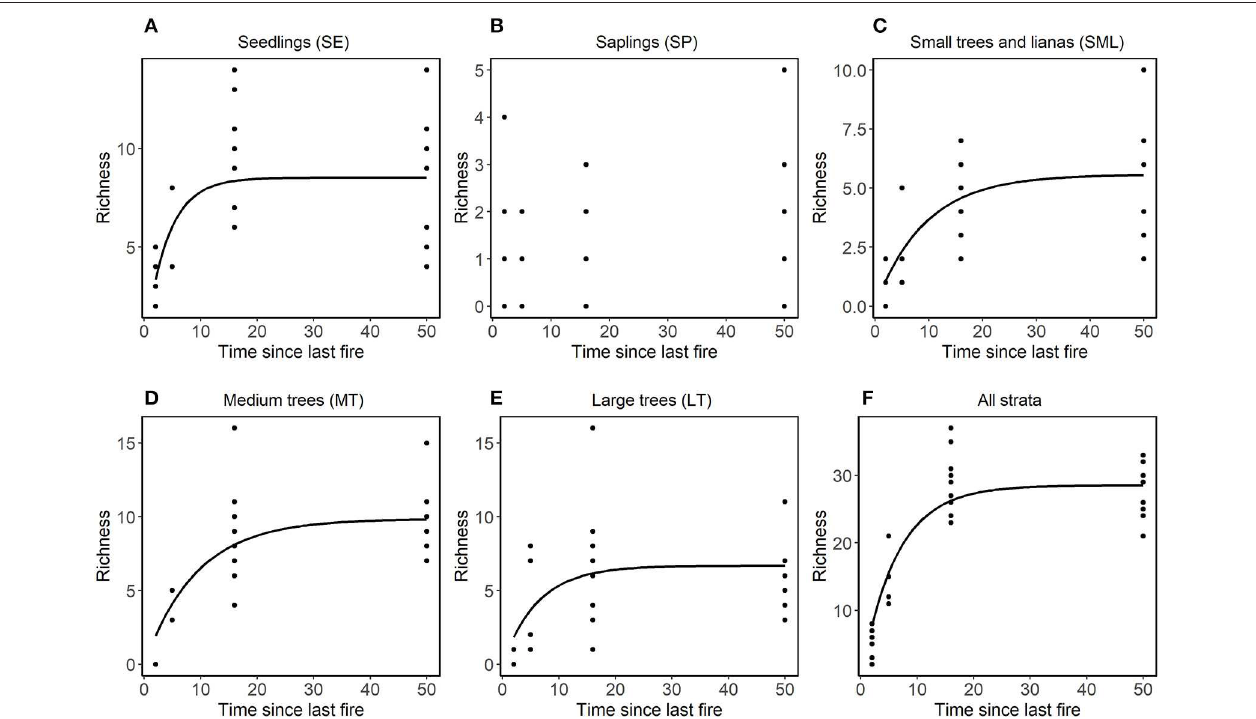
FIGURE 4 | Relationship in each stratum between richness and time since the last fire (years). In non-linear models fitted using (nls procedure in R) with asymptotic models, the equation was conducted separately for each stratum of vegetation (A) SE, (B) SP, (C) SML, (D) MT, and (E) LT, and (F) for all strata together. LT stands for large trees, MT for medium trees, SML for small trees and woody lianas, SP for seedlings, and SE for seedlings. Only curves that showed significant differences were